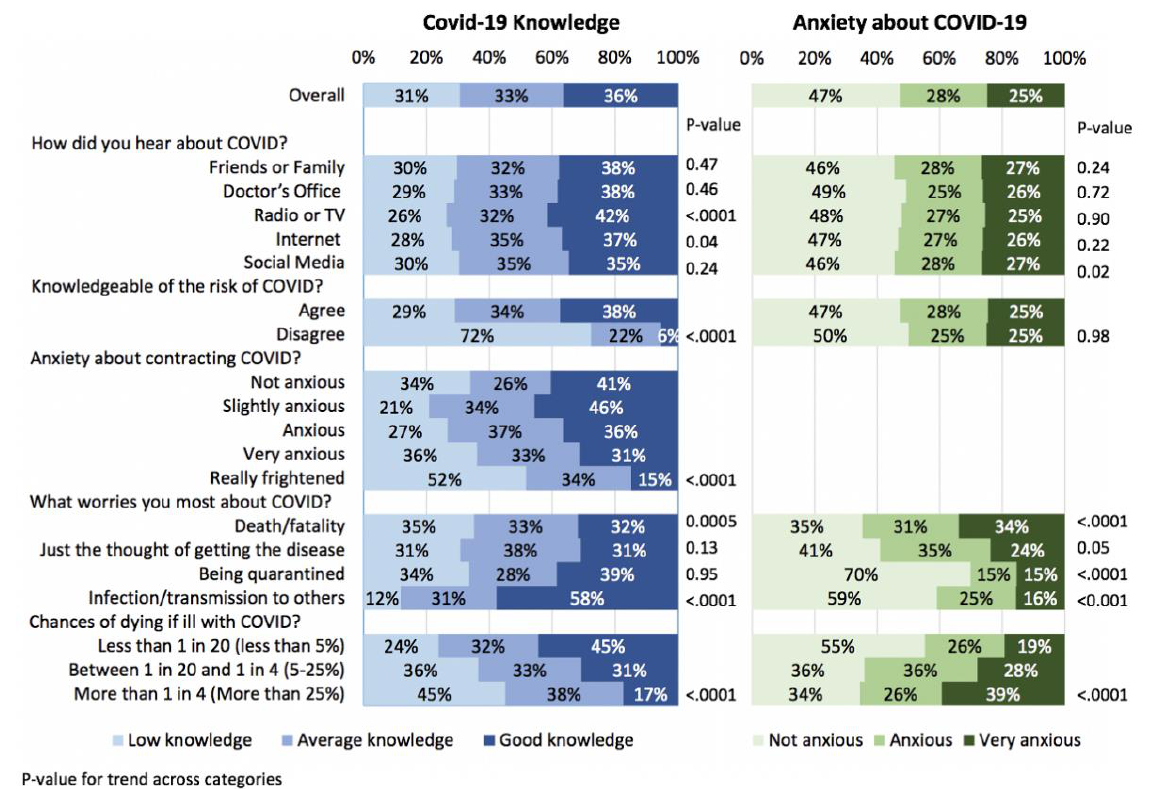
Figure 2. Association between participants’ answers to COVID-19 related questions, COVID-19 knowledge and anxiety about COVID-19 in 1658 responders to the survey. Table 3. Multivariable analysis of demographic factors associated with knowledge and